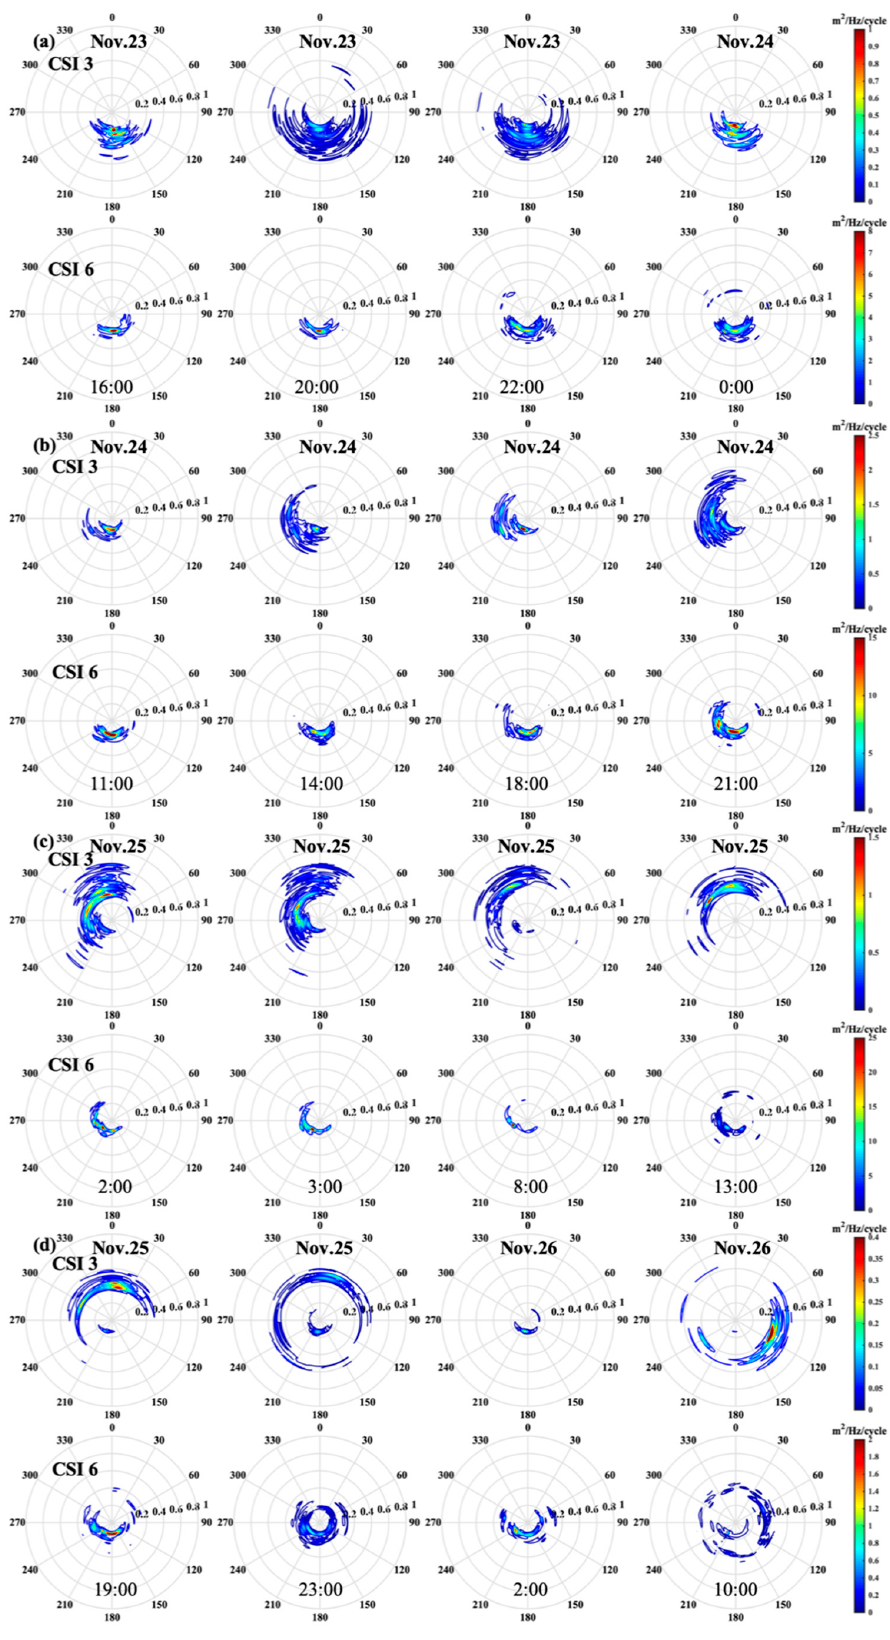
Figure 11. Hourly directional wave spectrum as observed by CSI 3 and CSI 6. The circles indicate the wave frequency from the center out with 0.1 Hz intervals. ( a ) Prefrontal phase, ( b ) frontal passage phase ( c , d ) postfrontal phase from November 23 to 26.